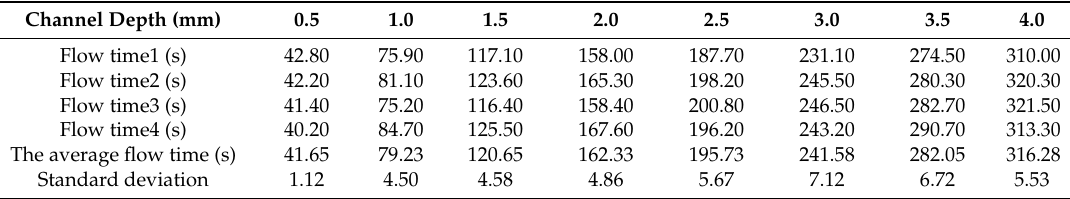
Table 1. Dye flow time in channels with different